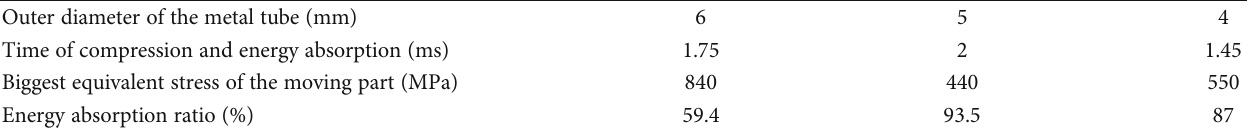
Table 2: Simulation results: compression and energy absorption process parameters for metal tubes of di ff erent diameters. Outer diameter of the metal tube (mm)